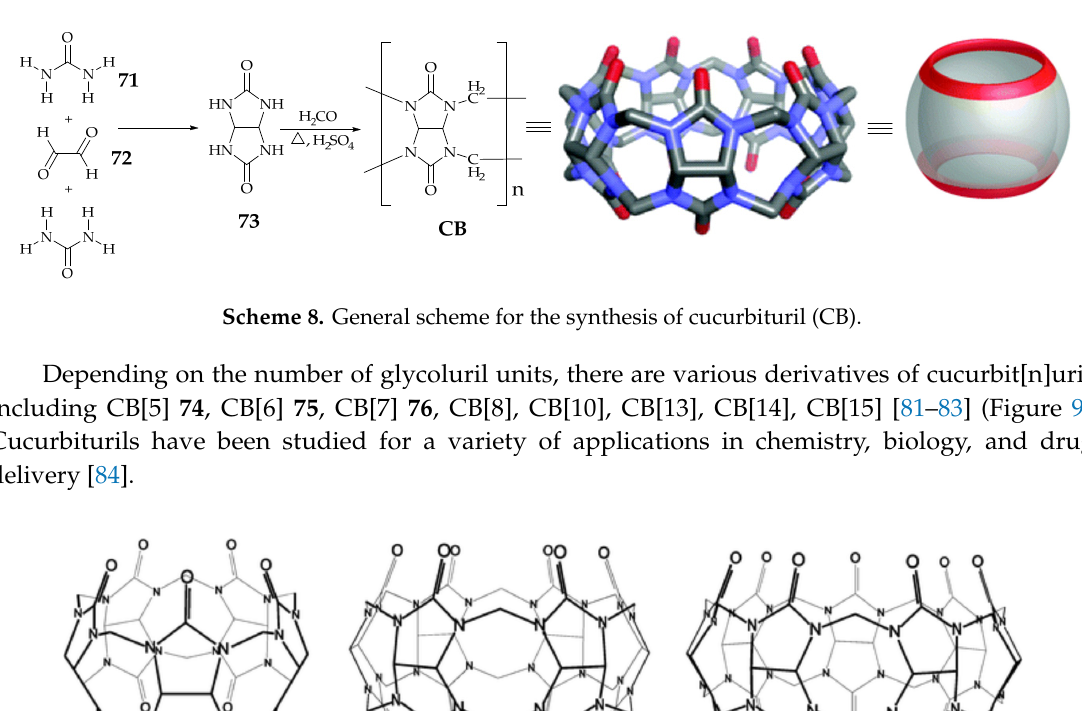
Scheme 8. General scheme for the synthesis of cucurbituril (CB).